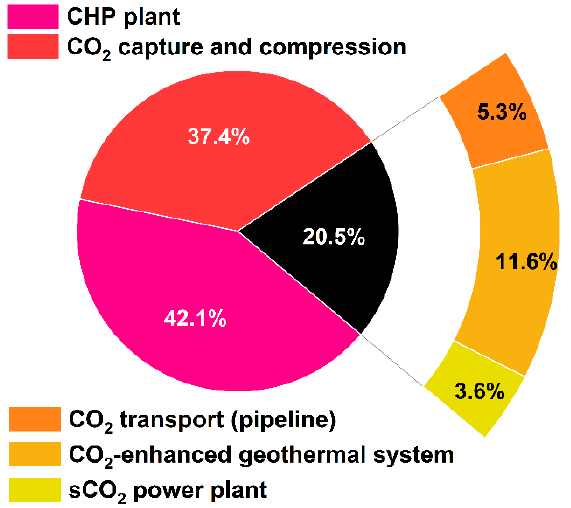
Figure 10. The share of system costs for parts of the analyzed system with respect to the total system cost.